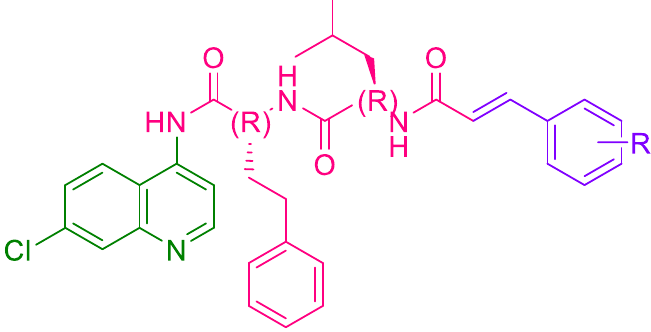
Figure 43. 4-aminoquinoline/cinnamic acid conjugates.